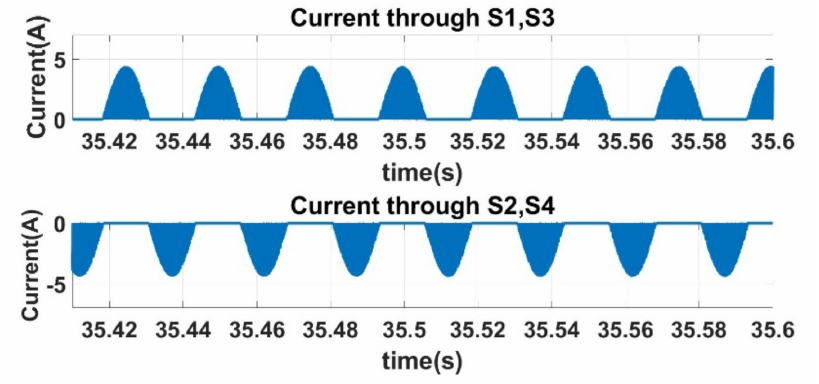
Figure 8. Simulated current through switches S1, S2, S3, and S4 of the battery bridge during discharge.